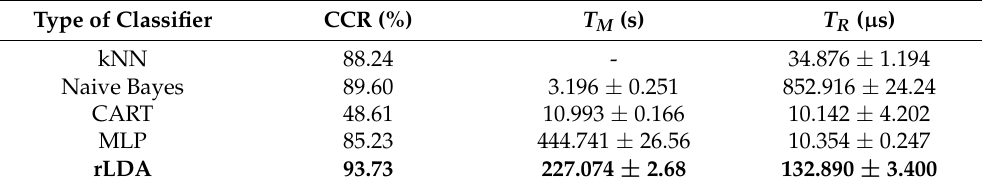
Table 5. Classification results for individual classifiers with Group 4 attributes.